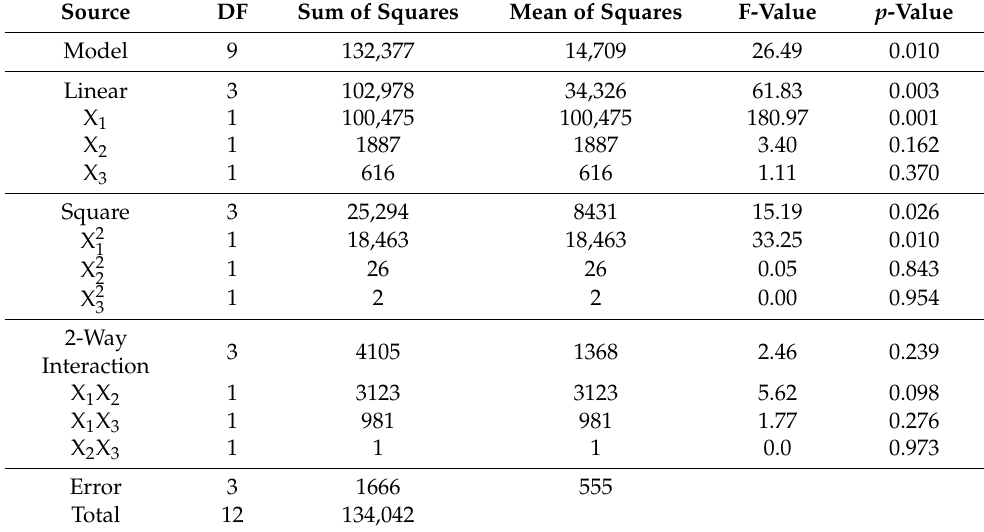
Table 8. Analysis of variance for viscosity response.